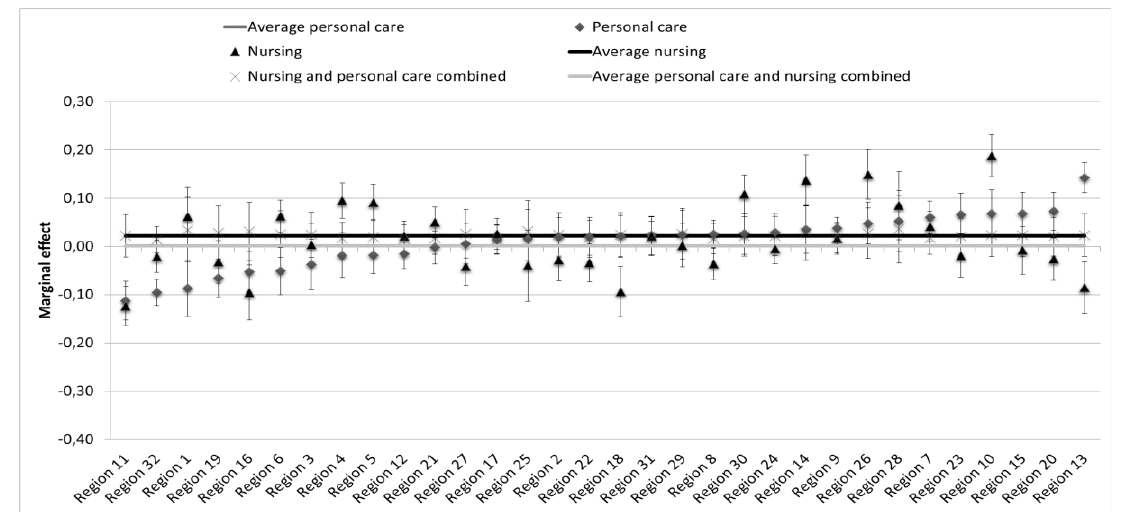
Figure A3: Variation in home care entitlements granted not processed by CNAC 65+